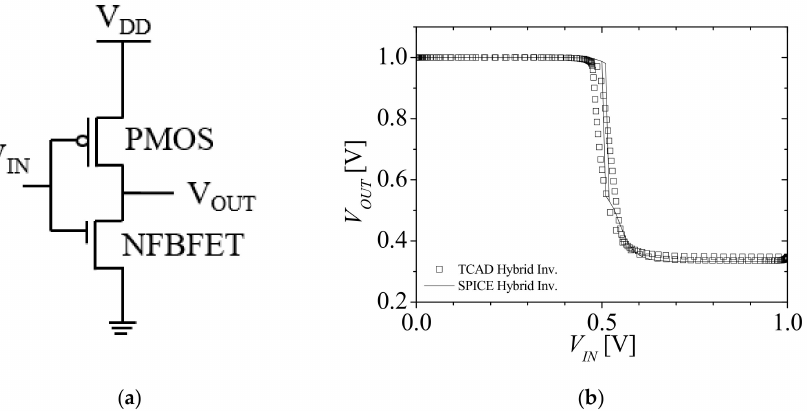
Figure 7. Circuit diagram of ( a ) a hybrid inverter and ( b ) the voltage transfer characteristics (VTCs) for TCAD and SPICE.